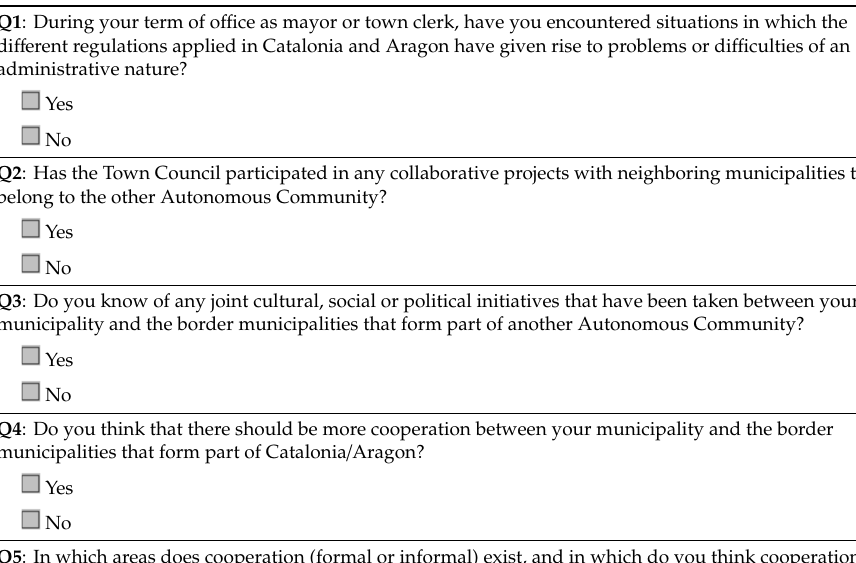
Table 1. Questionnaire used in this study (source: authors).